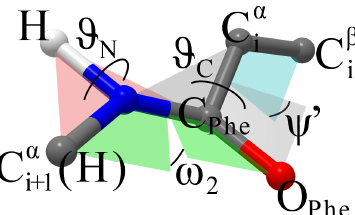
Figure 3. Possible distortions of the second amide group and the definition of the torsional angles ϑ C , ϑ N , ω 2 and ψ (cid:48) .